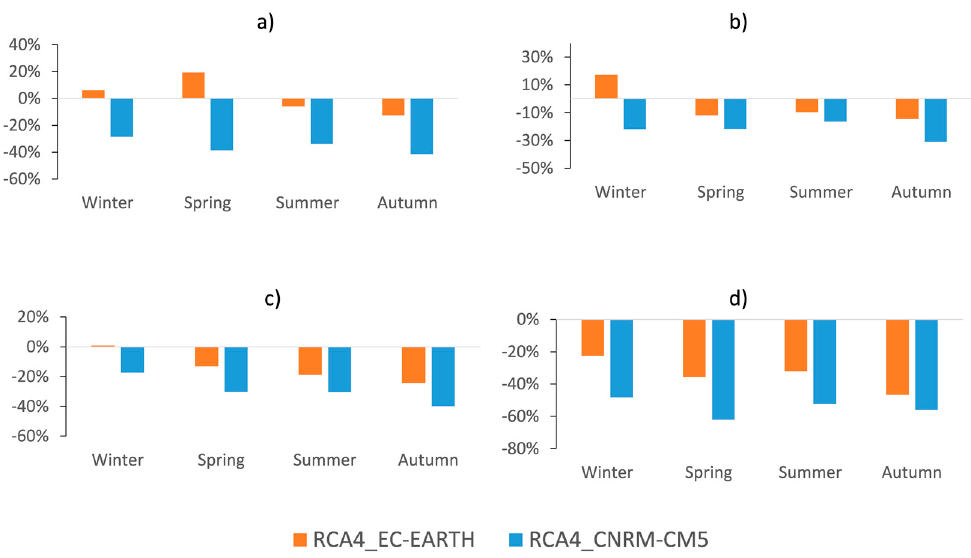
Figure 6. Seasonal evolution of the mean streamflow in ( a ) RCP4.5 (2041–2070); ( b ) RCP4.5 (2071–2100); ( c ) RCP8.5 (2041–2070); and ( d ) RCP8.5 (2071–2100).